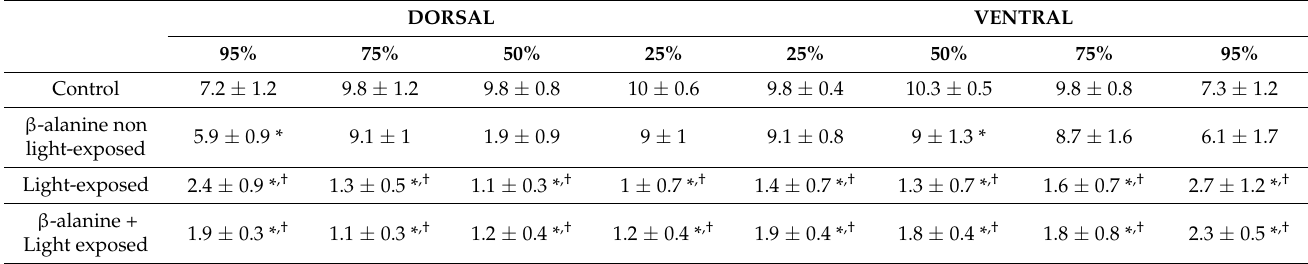
Table 2. Number of nuclei rows in the outer nuclear layer in control and experimental animals. DORSAL